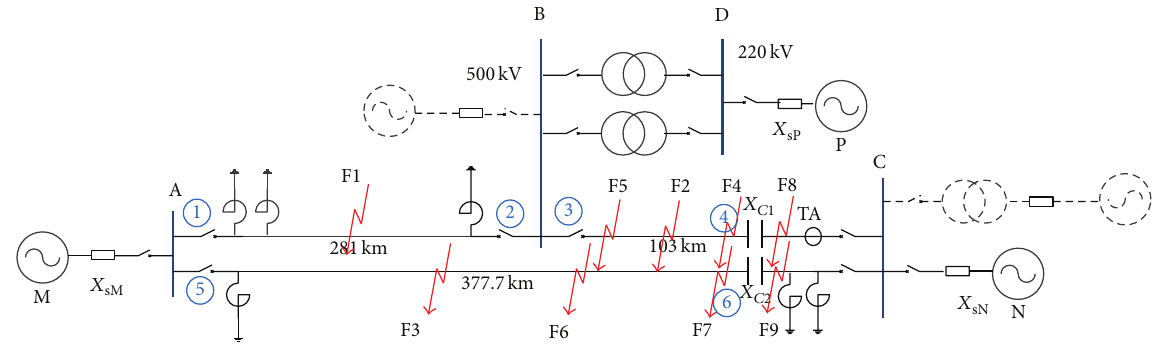
Figure 1: Simulation model of power